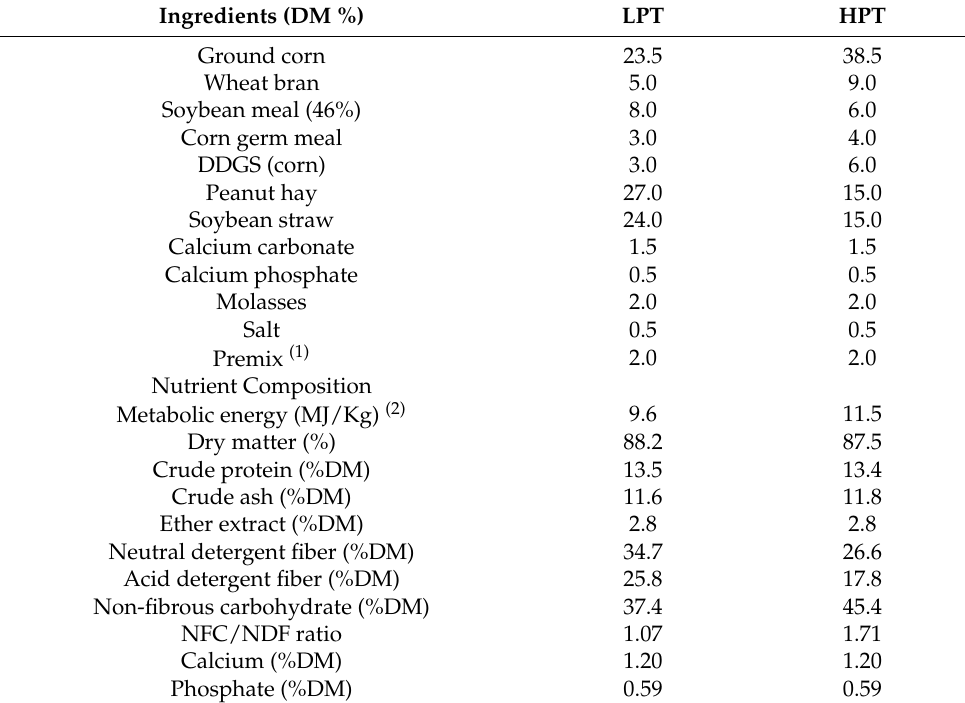
Table 1. Ingredients and chemical compositions of low and high NFC to NDF ratio pelleted TMR (DM basis